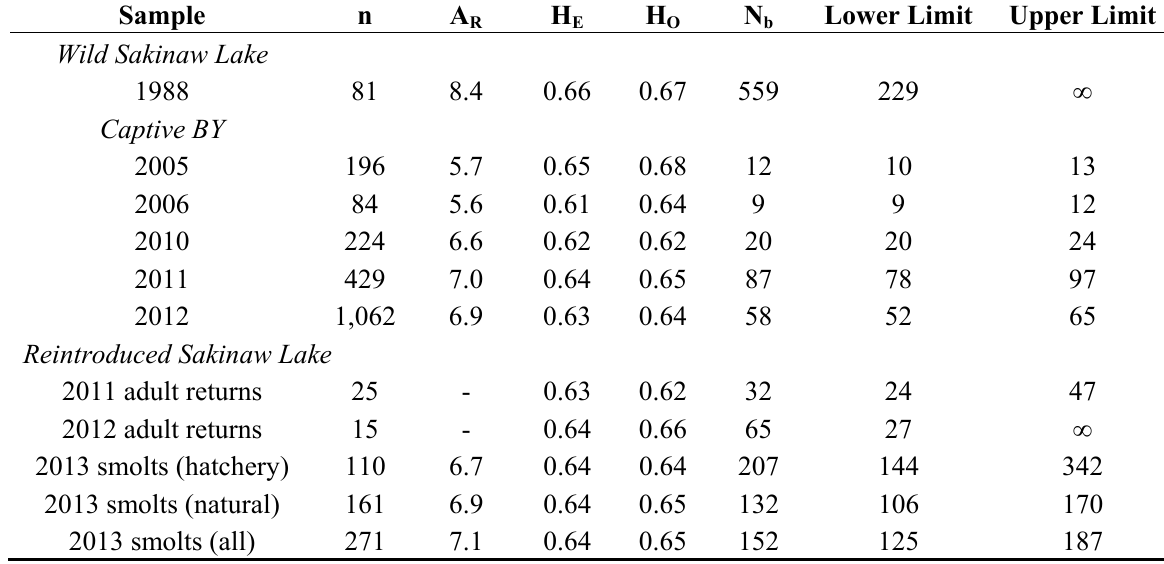
), expected (H ) and observed (H R E ) for wild, captive and reintroduced b estimates are b